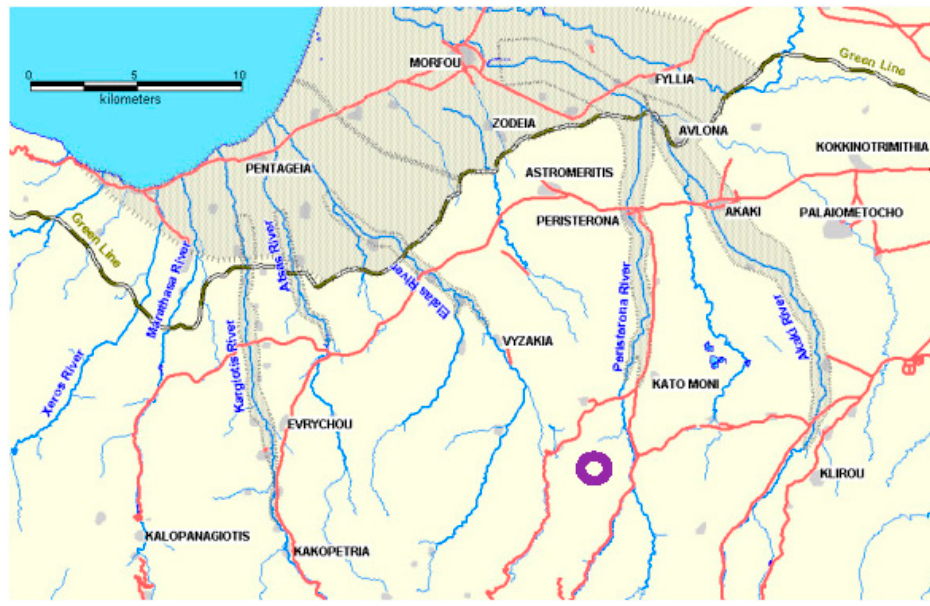
Figure 3. Location of the Kato Moni site (purple circle). After [22].